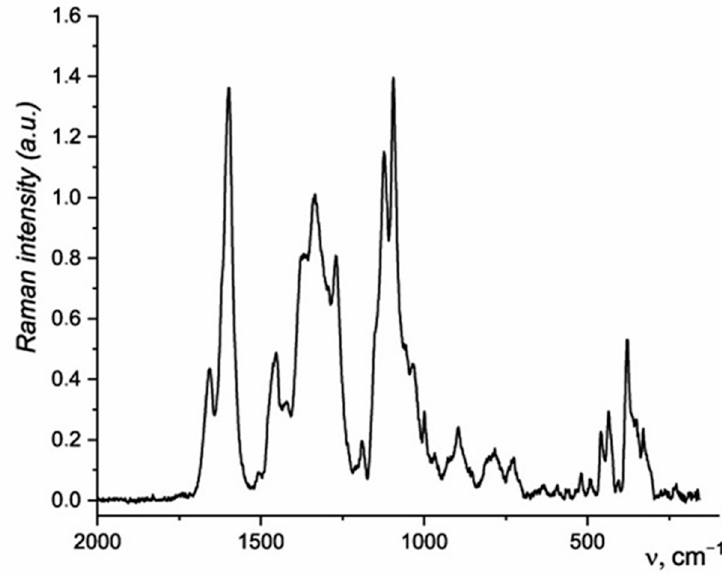
Figure 4. Raman spectrum of sawdust.